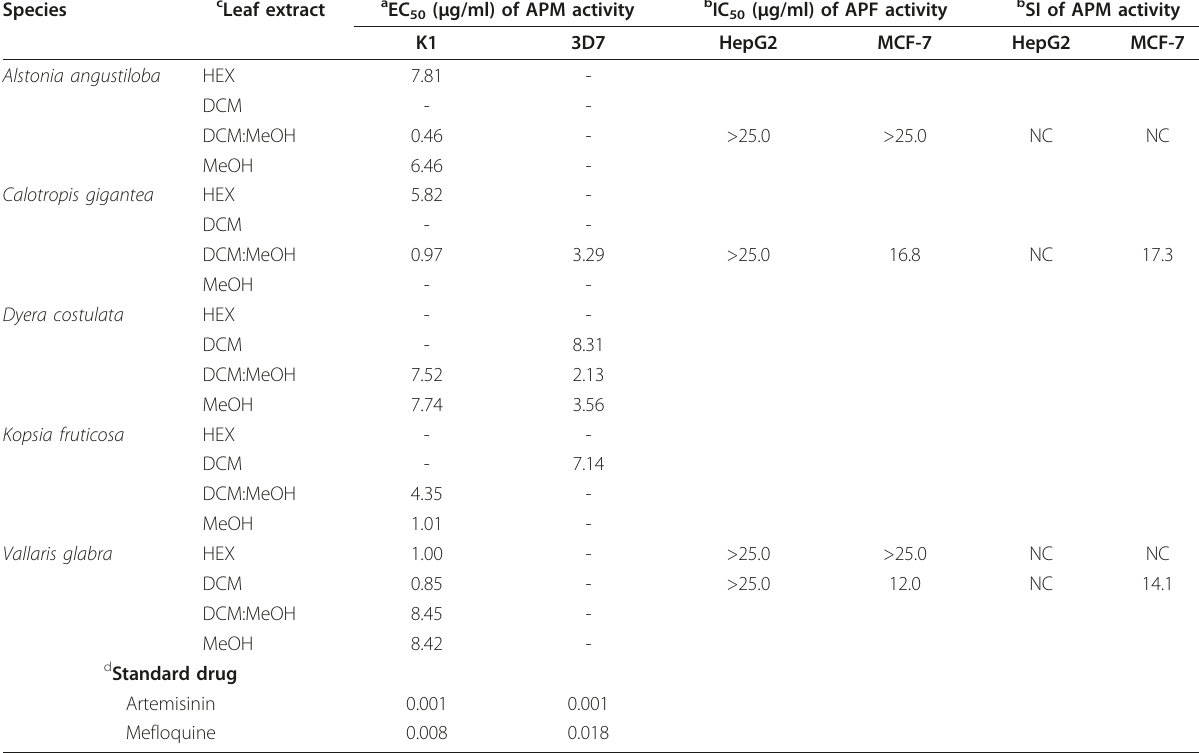
Table 2 Antiplasmodial (APM) activity and selectivity index (SI) of leaf extracts of Apocynaceae species